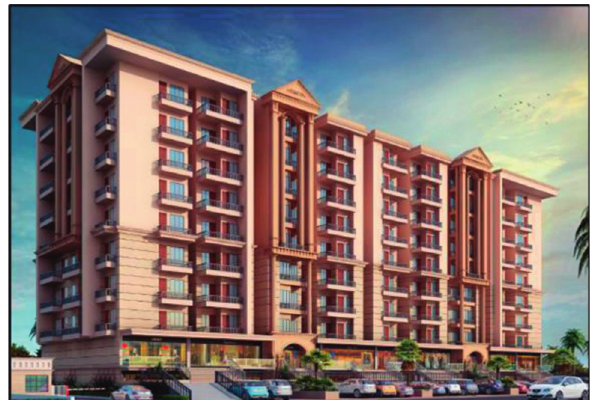
Figure 1: Rendering of the finished project.